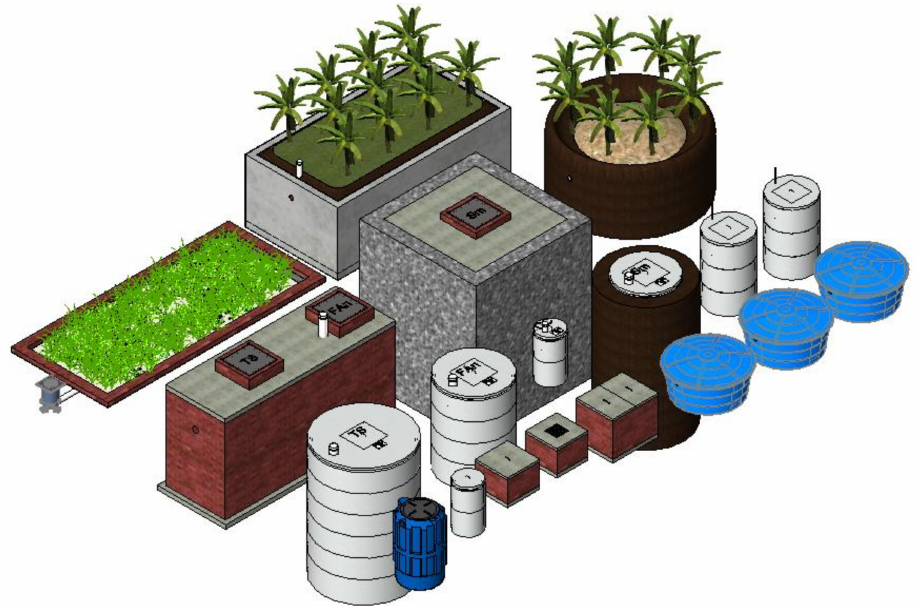
Figure 1. DEWATS in the specific template. Source: authors